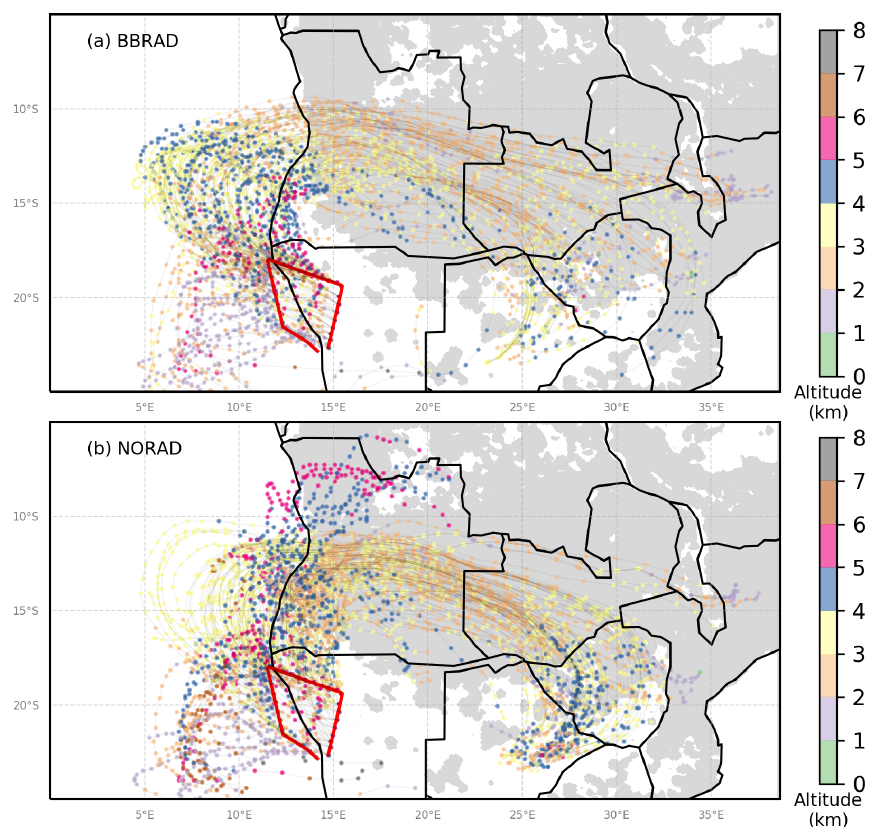
Figure 7. Selected trajectories of BB tracers ending along the LNG track (red line) at 09:00UTC on 6 September 2017 in (a) BBRAD and (b) NORAD. Their position is indicated by dots every 3h. Their length is 5d and 9h. Fire sources are shaded in grey. Results are shown for the BBRAD and NORAD members starting at 00:00UTC on 1 September